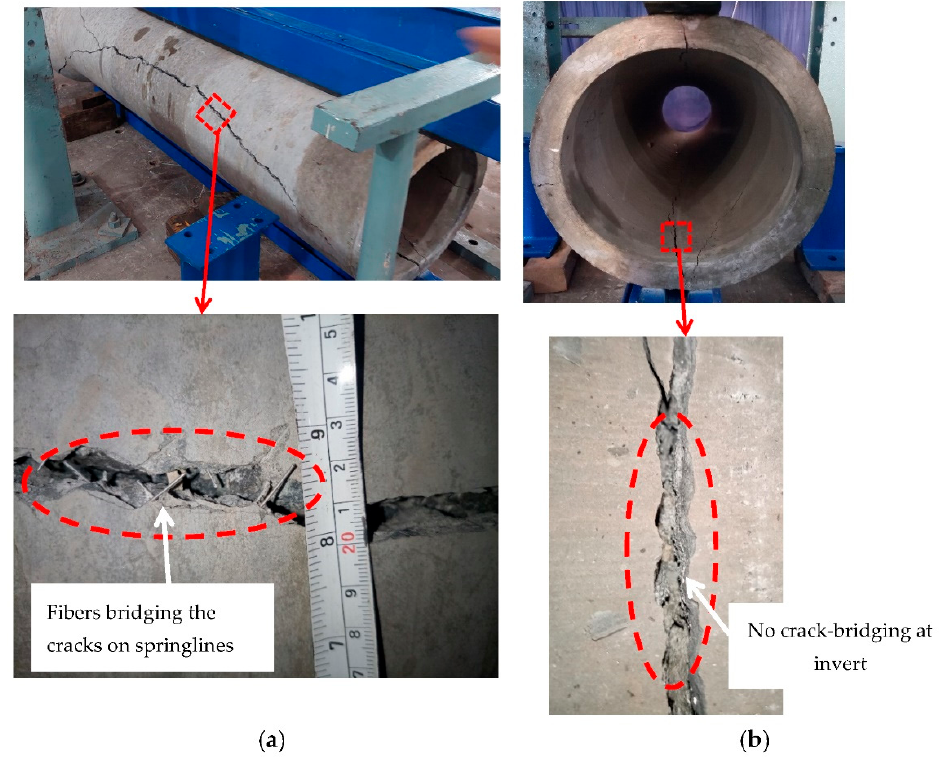
Figure 18. Cracking pattern of the tested concrete pipe incorporating steel fibers: ( a ) crack along springlines, ( b ) crack at invert.